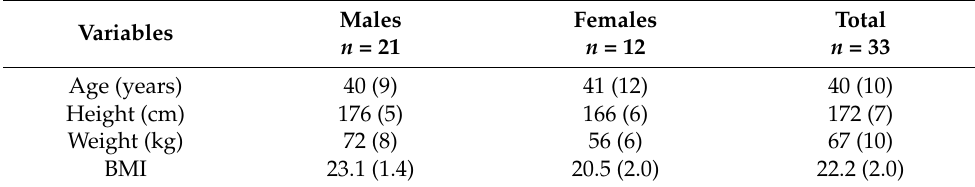
Table 1. Characteristics of the population studied. Data are reported as mean (SD).